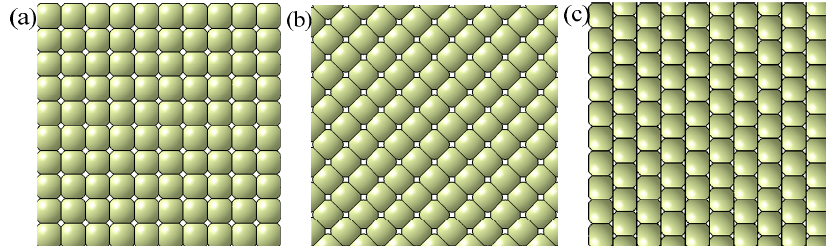
Figure 5. Arrangement modes of basic units: ( a ) conventional arrangement; ( b ) declining staggered arrangement; ( c ) parallel staggered arrangement.